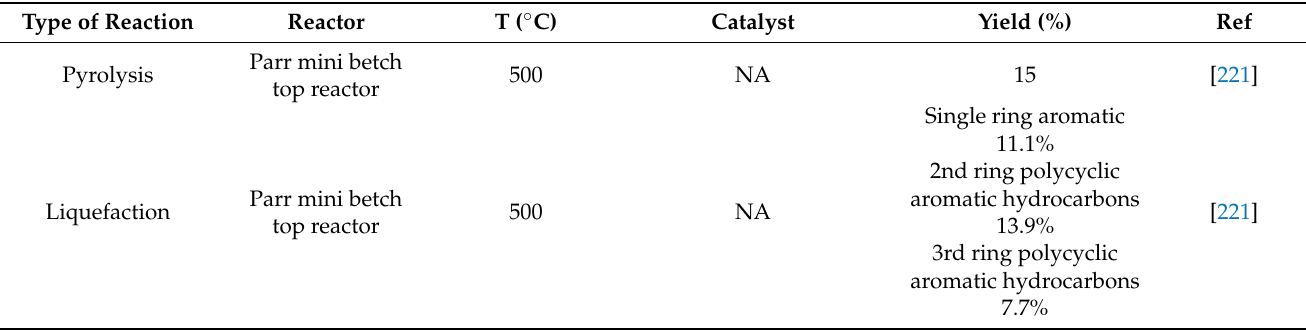
Table 5. The various kind of reactor of recycling PET with product